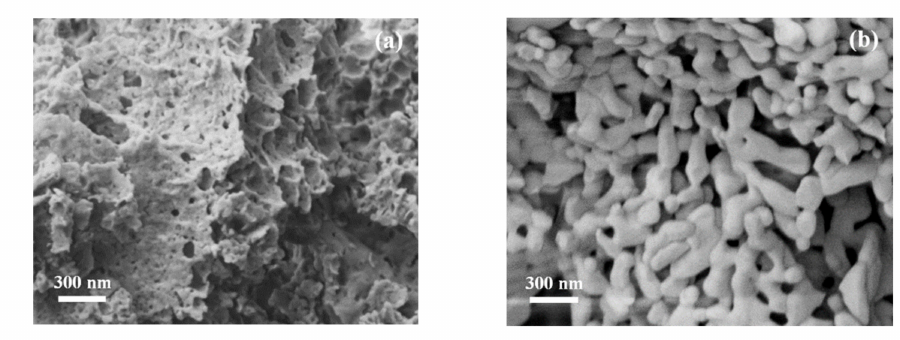
Figure 4. SEM micrographs for gadolinium aluminate heat treated at 900 ◦ C for 1 h ( a ) and at 1000 ◦ C for 7 h ( b ).